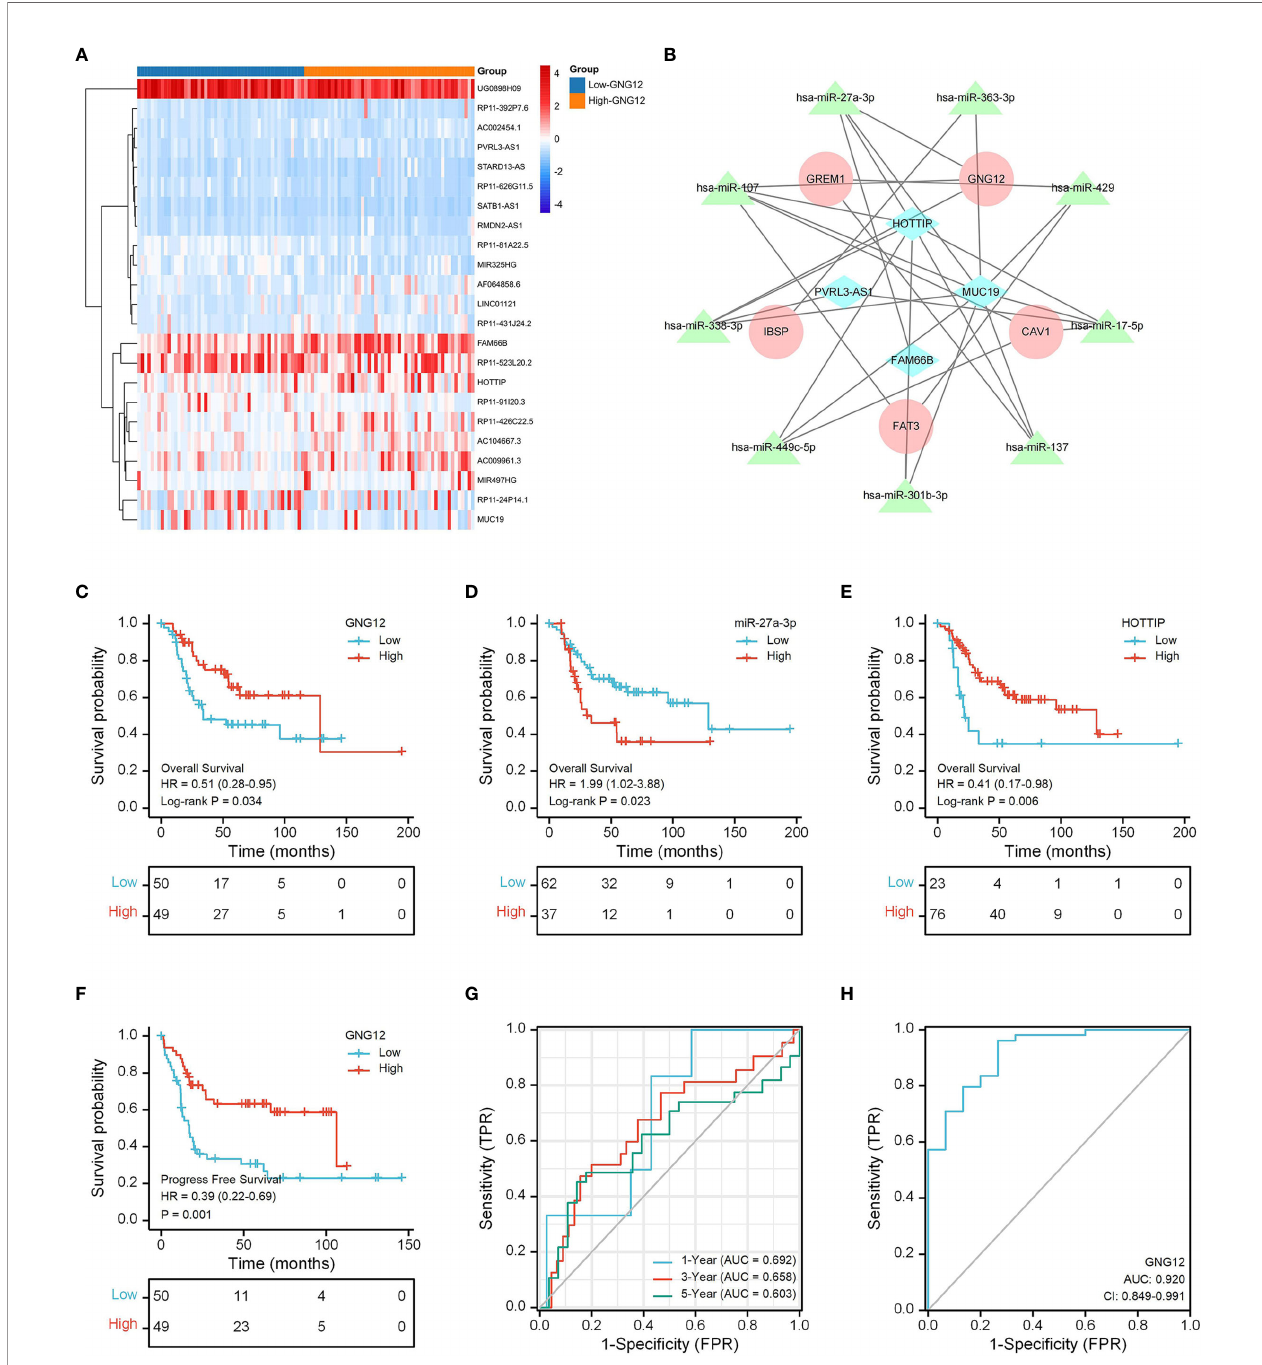
FIGURE 8 | GNG12-related ceRNA network construction and survival analysis. (A) The TARGET data set shows the signi fi cant difference lncRNAs between the two groups in the form of a heat map. (B) A ceRNA network: blue diamond, lncRNAs; green triangle, miRNAs; red round, mRNAs. (C) The effect of low GNG12 expression on the prognosis of osteosarcoma overall survival (OS) is statistically signi fi cant. (D) The effect of high miR-27a-3p expression on the prognosis of osteosarcoma overall survival (OS) is statistically signi fi cant. (E) The effect of low HOTTIP expression on the prognosis of osteosarcoma overall survival (OS) is statistically signi fi cant. (F) The effect of low GNG12 expression on the prognosis of osteosarcoma progress-free survival (PFS) is statistically signi fi cant. (G) Time-dependent ROC curves, 1 year (AUC = 0.692), 3 years (AUC = 0.658), and 5 years (AUC = 0.603). (H) The area under the ROC curve (AUC) in the GEO set assesses the performance for distinguishing osteosarcoma from normal tissue of GNG12 (AUC =